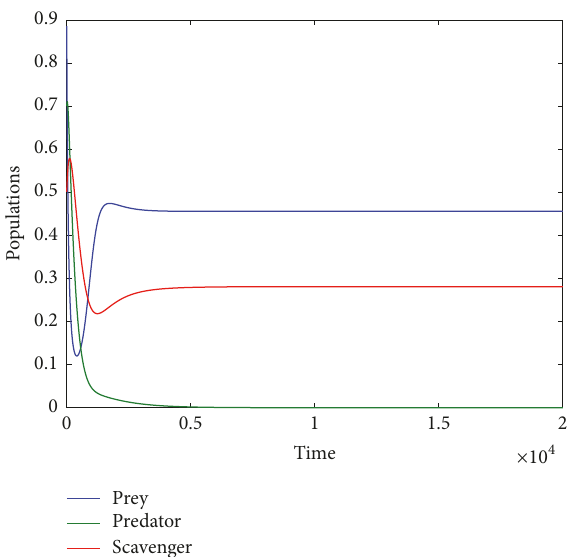
Figure 5: Time series for the solution of system (3) using data (76) with 𝛿 = 0.3 . The system approaches 𝐸 3 = (0.45,0,0.28)